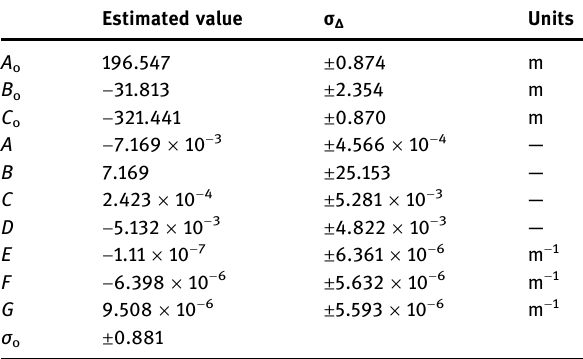
Table 2: Coe ffi cients of the polynomial